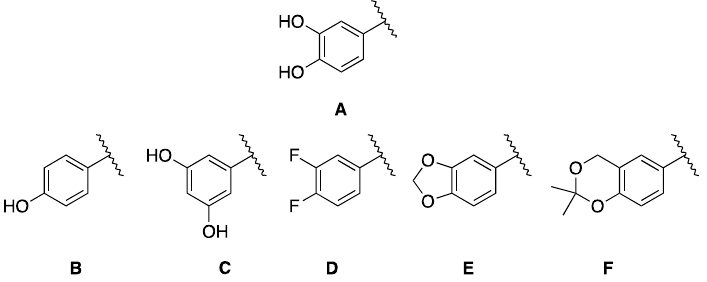
Figure 2. Replacements for the catechol groups (A) of rooperol.